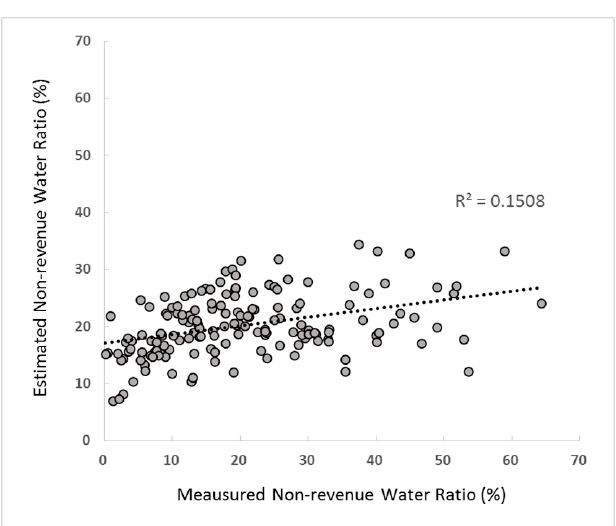
Figure 12. Scatter Plot of NRW Ratio Using Nonlinear MRA Results.